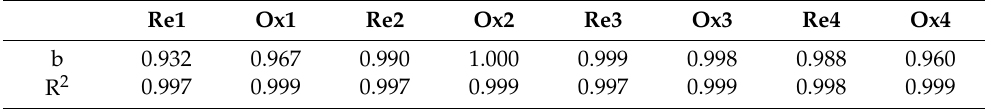
Table 2. Values of b Equations (1) and (2) and regression coefficients (R 2 ) derived from the fitting current of reduction peaks (Re) and oxidation peaks (Ox) at various scan rates.